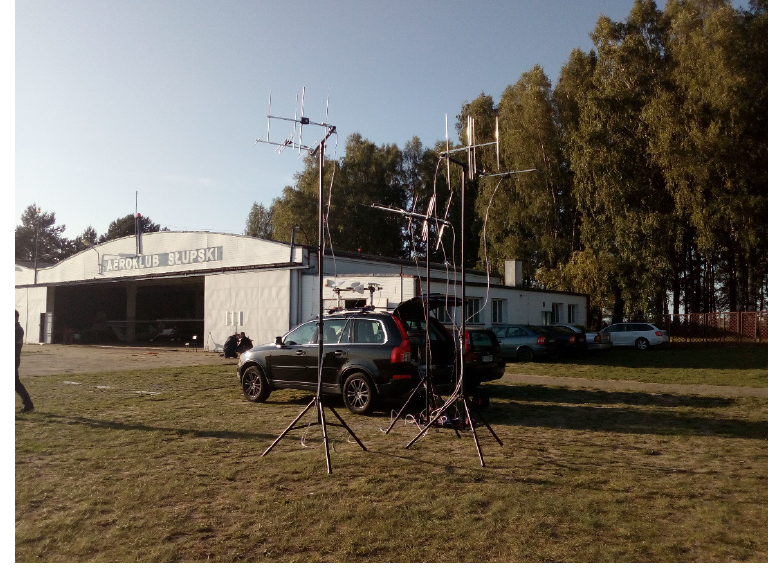
Figure 3. Radar demonstrator during measurements. Table 1. Main parameters of the transmitter of